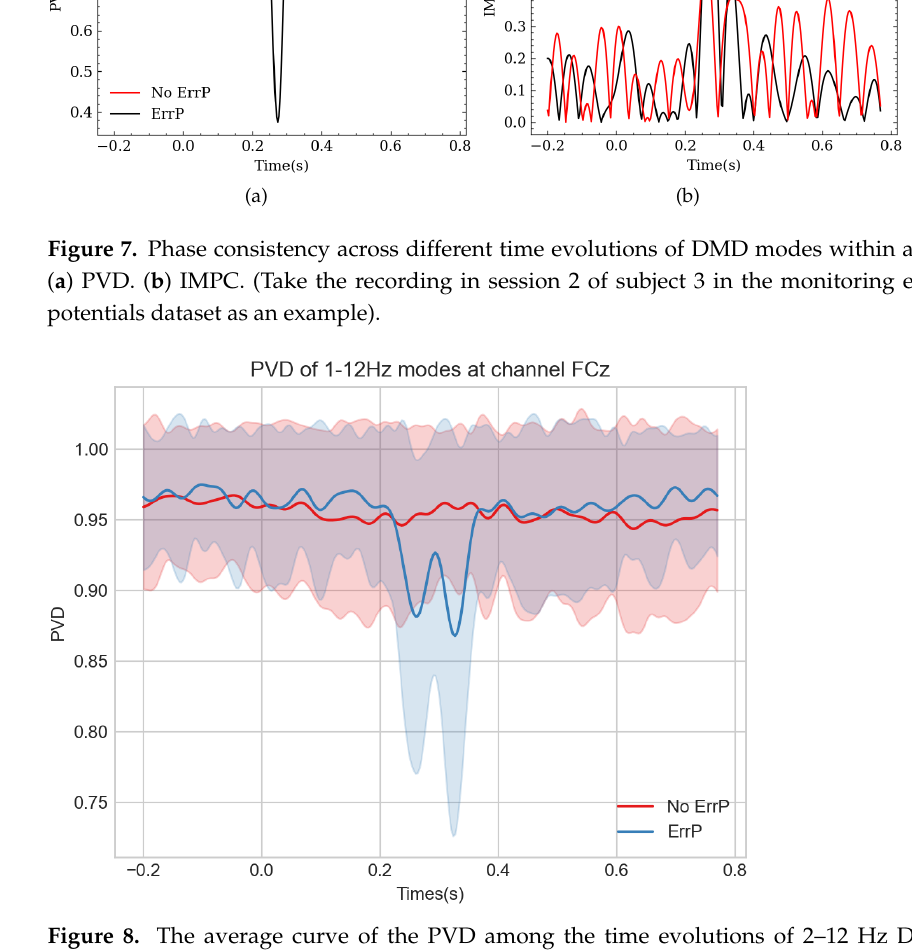
Figure 8. The average curve of the PVD among the time evolutions of 2–12 Hz DMD modes calculated from all trials of subject 3 in the public dataset. The shaded area is the upper and lower standard